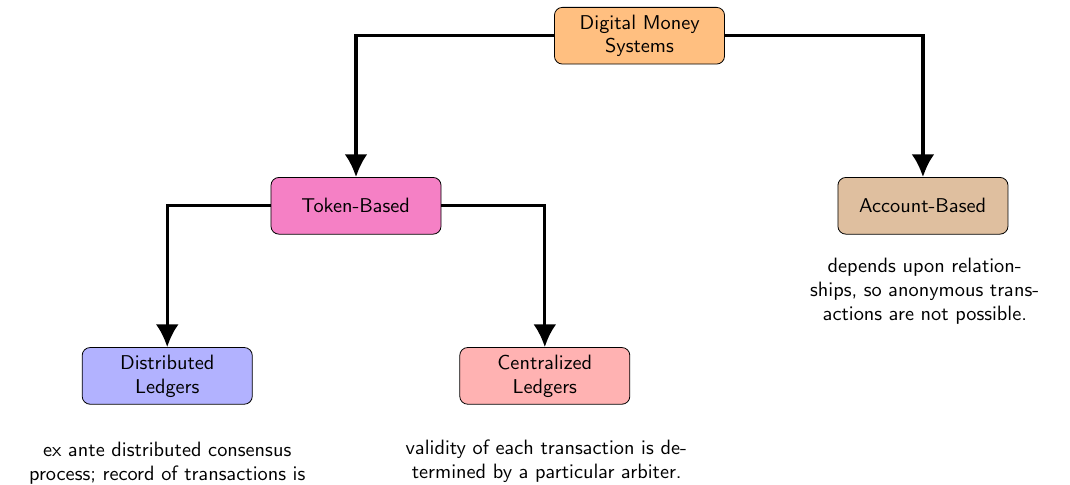
Figure 1. Taxonomy of digital money